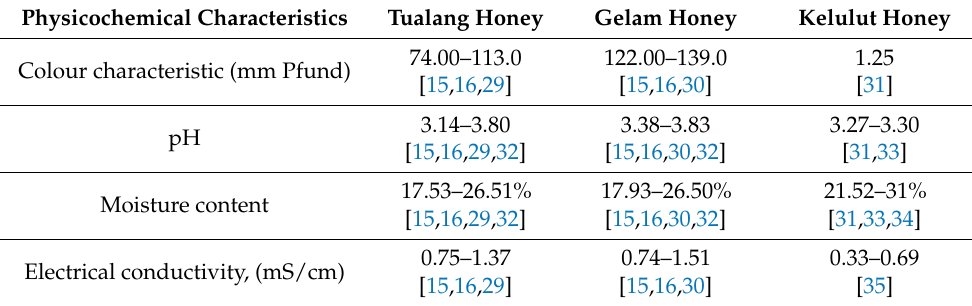
Table 1. Physicochemical characteristics of Tualang, Gelam and Kelulut honeys.